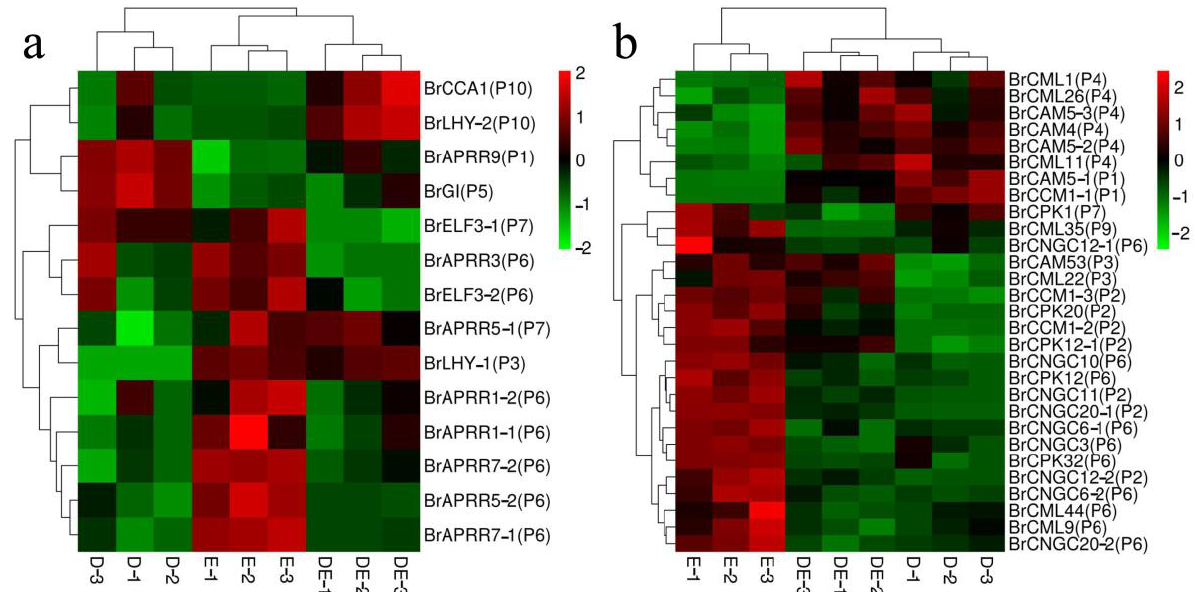
Figure 5. Heat map of differential expression genes related to heterosis. ( a ) The cluster heatmap of genes involving in circadian rhythm-plant pathway. ( b ) The cluster heatmap of genes regulating calcium. Green indicates the lowest expression. Red indicates the highest expression. The gene expression pattern is indicated in parentheses. D represents the female parent in the cross combination with strongest heterosis. E represents the male parent in the cross combination with strongest heterosis. DE represents the hybrid in the cross combination with strongest heterosis.